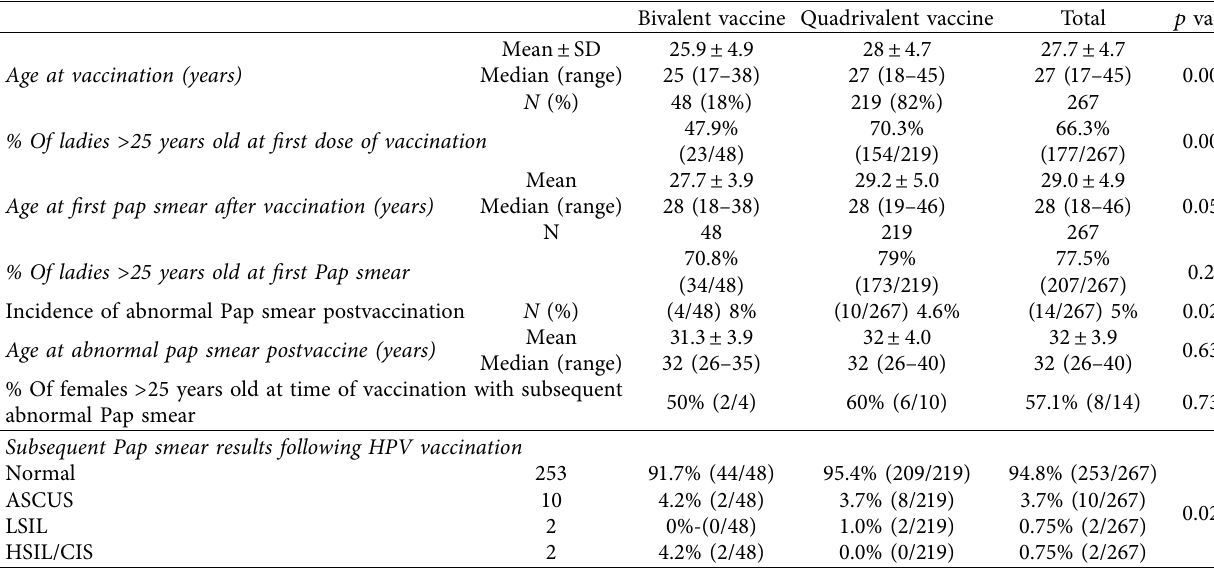
Table 2: Cervical cytology screening in women who were not initially sexually active and received the human papilloma virus vaccine at the Women’s Health Center (WHC) of the American University of Beirut-Medical Center (AUBMC) 2007–2017. Bivalent vaccine Quadrivalent vaccine Total